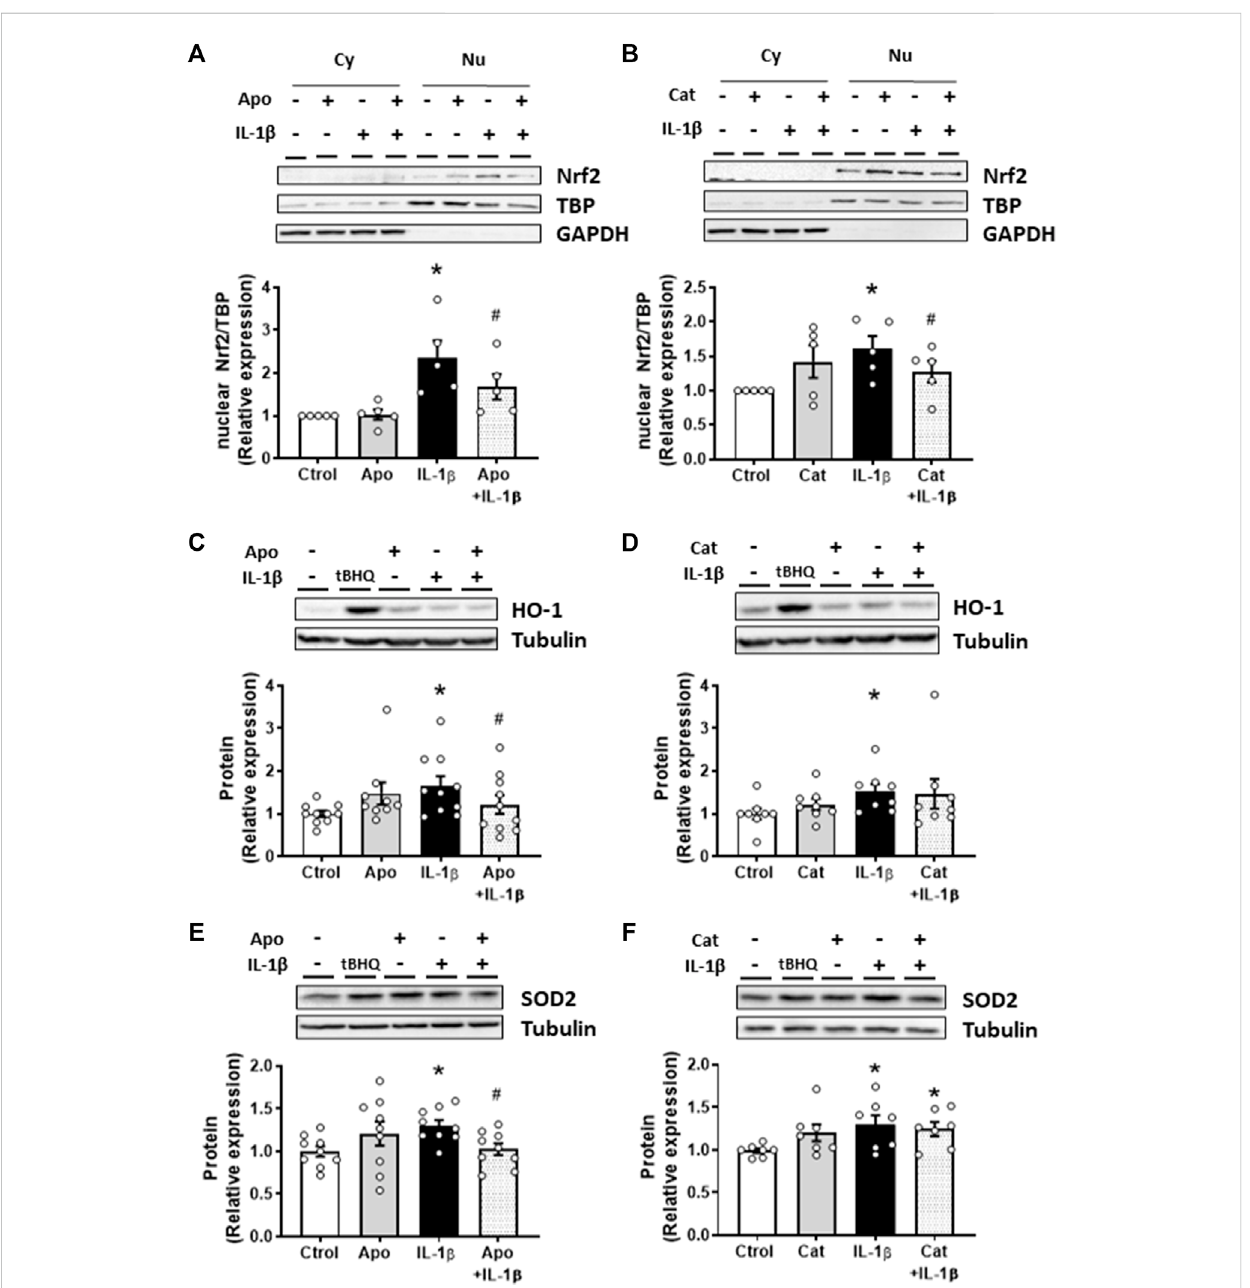
RoleofoxidativestressintheIL-1 β -inducedeffectsontheNrf2pathway.Effectofapocynin(Apo,30 μ M,2 h)andcatalase(Cat,1,000 U/mL,2 h)on the nuclear Nrf2 (nuclear factor-erythroid 2-related factor 2) protein expression (A,B) induced by Interleukin-1 β (IL-1 β , 10 ng/mL, 1 h) in vascular smooth muscle cells; a representative blot of the cytosolic (Cy) and nuclear (Nu) expression is also shown; nuclear TATA-binding protein (TBP) and cytosolic GAPDH expressions are also shown to guarantee the successful cellular fractioning. Effect of Apo and Cat on heme oxygenase-1 [HO-1, (C,D) ] and superoxide dismutase 2 [SOD2, (E,F) ] protein expressions induced by IL-1 β . Representative blots are shown in upper panels. Tert-butylhydroquinone (tBHQ, 20 μ M, 24 h) was used as positive control. * p < 0.05 vs. control; # p < 0.05 vs. IL-1 β by Student ’ s t -test ( n = 6 –